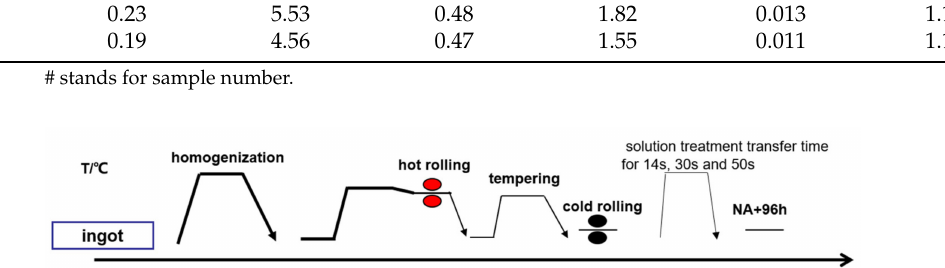
Figure 1. Schematic diagram of deformation and heat treatments used for 2024-T3